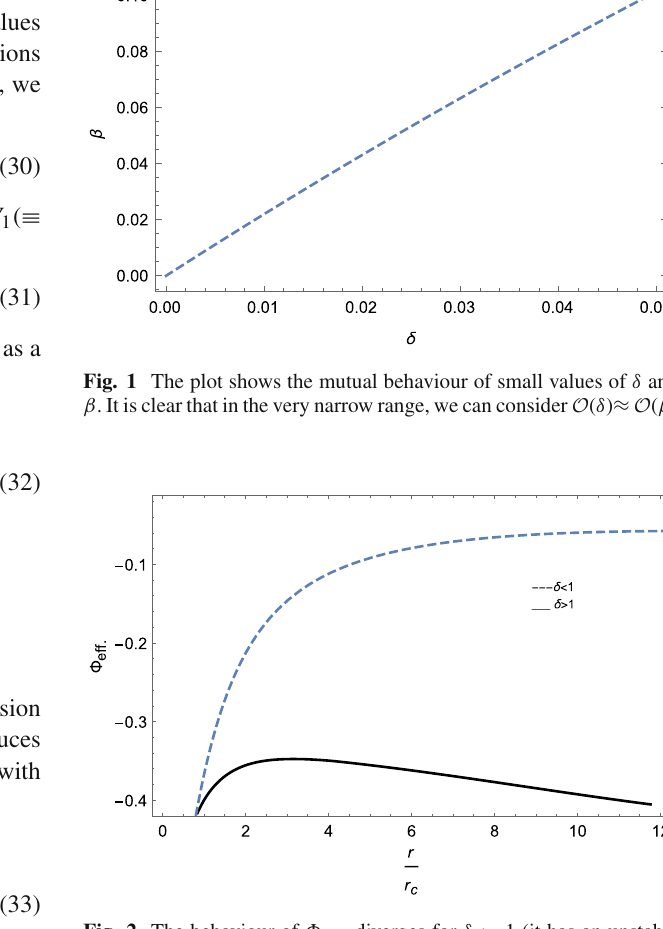
Fig. 2 The behaviour of (cid:18) ef f diverges for δ > 1 (it has an unstable profile), whereas δ < 1 has a suitable profile for the interpretation of > galactic dynamics with r r c